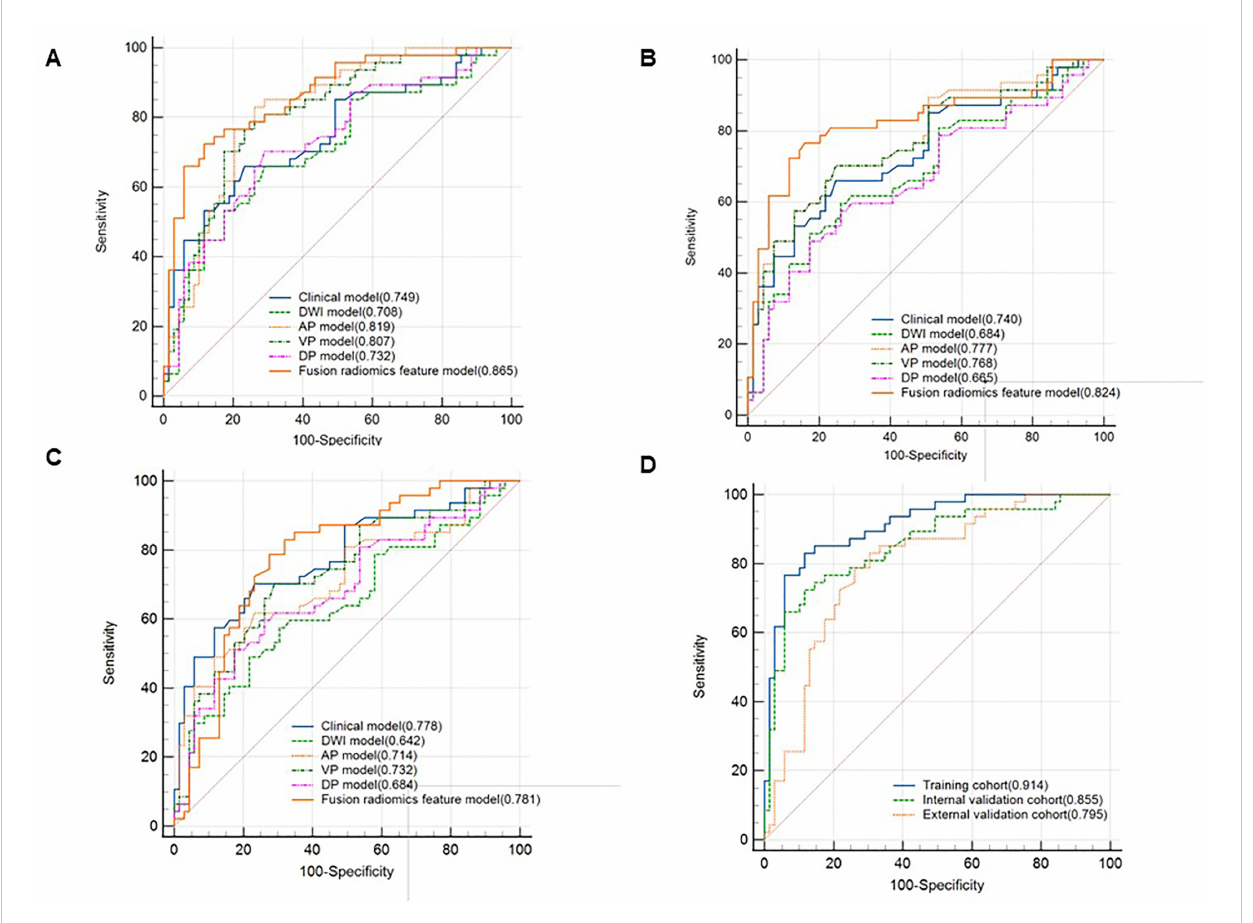
FIGURE 3 Comparison of receiver operating characteristics (ROC) curves for predicting CK19 status. ROC curves of the clinical, DWI, AP, VP, DP and fusion radiomics feature model in the training cohort (A) , internal validation cohort (B) and external validation cohort (C) . ROC curves of combined clinical with fusion radiomics feature model in the three cohorts (D) .